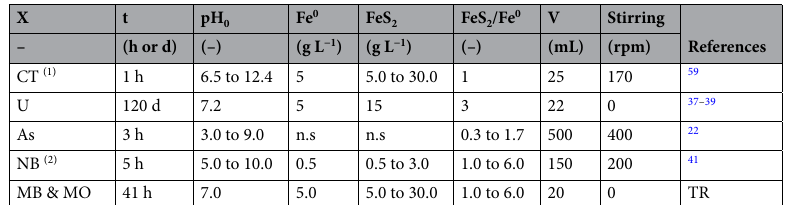
Table 5. Overview of selected experimental conditions used for batch experiments in investigating the role of FeS 2 in enhancing the efficiency of Fe 0 /H 2 O systems. X stands for the used contaminant. Only this research and refs. 37–39 have used quiescent systems and experimental durations longer that one day. (1) Carbon tetrachloride; (2) Nitrobenzene; TR This research.